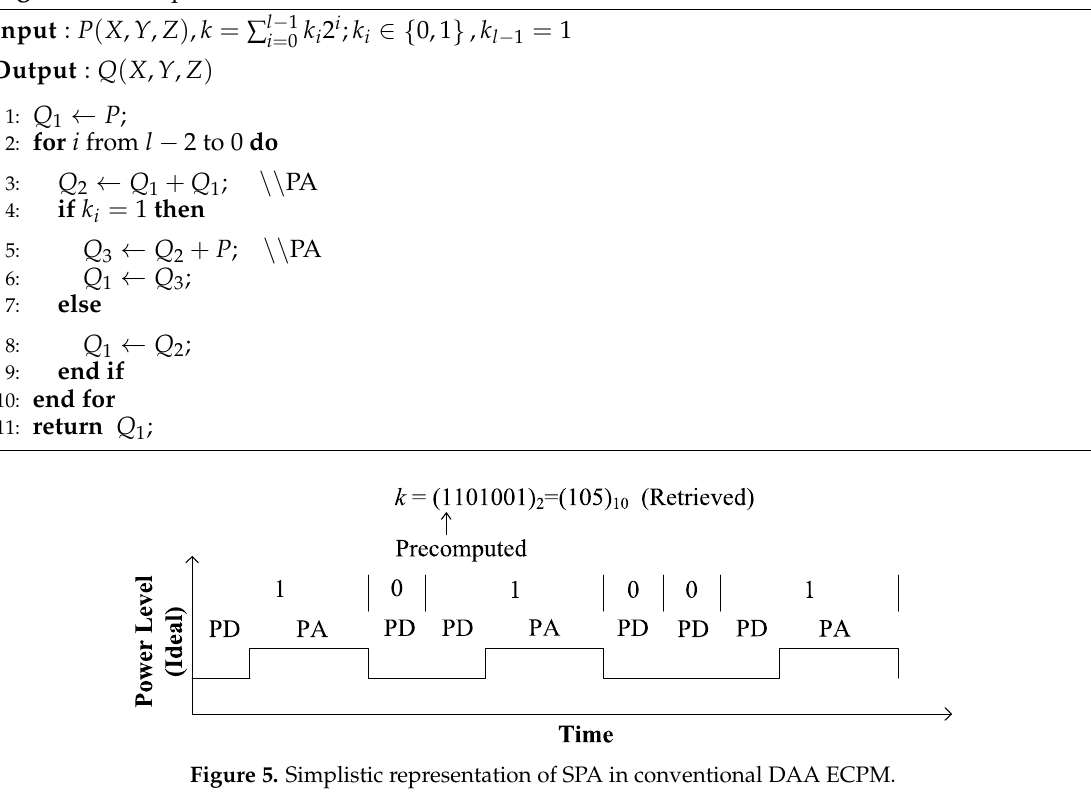
Algorithm 4 Proposed Unified PA-based ECPM